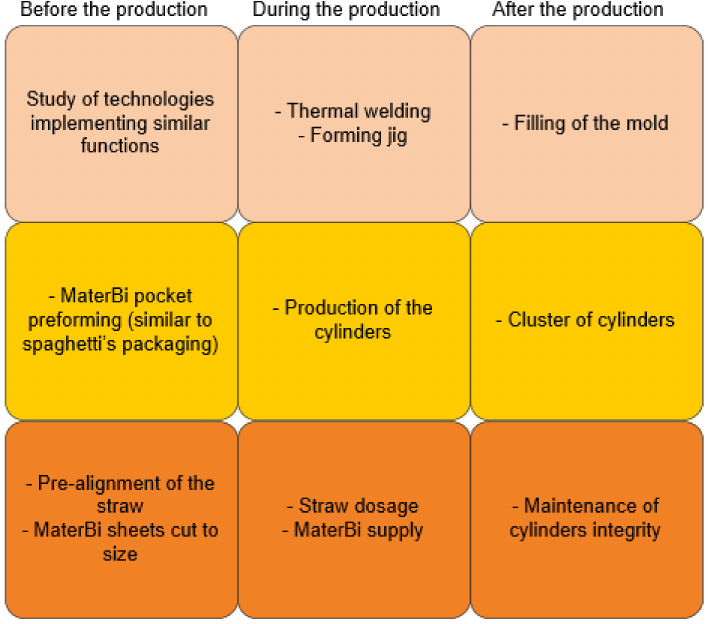
Figure 5. Hints obtained from the classic SO